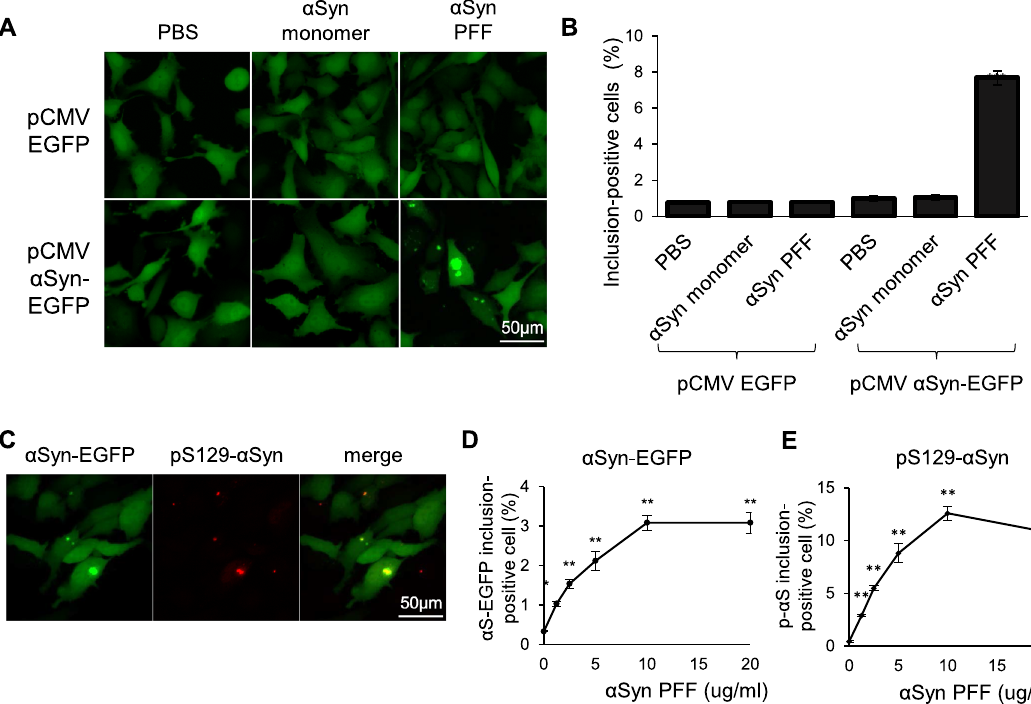
Figure 2. Establishment of a cell-based assay to evaluate αSyn aggregation. ( A ) Representative images of αSyn- EGFP aggregation in HeLa cells. HeLa cells were transfected with the indicated plasmids, and then treated with PBS, αSyn monomers, or PFF. ( B ) Quantification of the percentage of cells containing obvious αSyn-EGFP inclusion bodies in ( A ). Data are shown as the mean ± SEM of twelve independent wells (n = 12; ** P < 0.01; two- way ANOVA with the Tukey test). ( C ) Representative immunocytochemistry images of PFF-treated HeLa cells. Cells were transfected with pCMV αSyn-EGFP, and then treated with αSyn PFF. Phosphorylated αSyn (pS129 αS) was stained using a specific antibody. ( D , E ) Quantification of the percentage of cells containing obvious αSyn-EGFP ( D ) and p129-αSyn ( E ) inclusion bodies. Data are shown as the mean ± SEM of four independent wells (n = 4; * P < 0.05; ** P < 0.01; one-way ANOVA with the Dunnett test compared with the no αSyn PFF